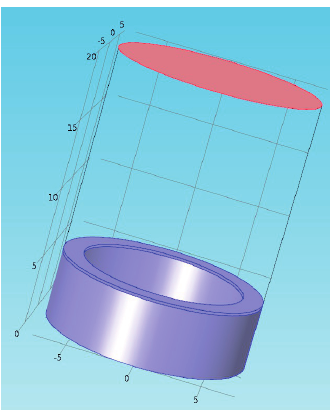
Figure 2. Geometry of the X-ray tube in SolidWorks. Red and blue parts are anode and cup-shaped cathode, respectively. CNC FE disk (diameter = 15 mm) is at the bottom offocusing cup; a 12-mm-diameter aperture is at the top of